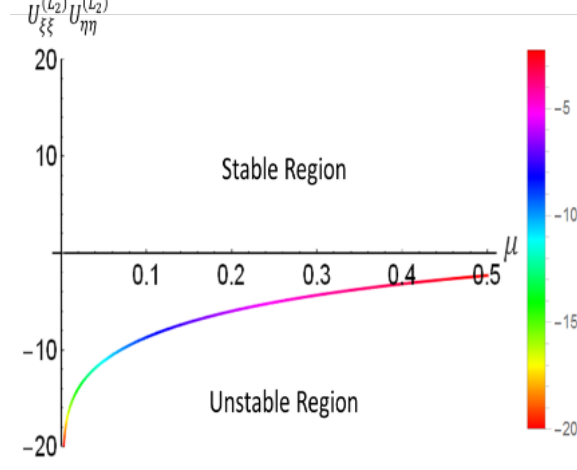
Figure 6. Stability region vs. µ for L 2 for ERTBP with oblate and triaxial